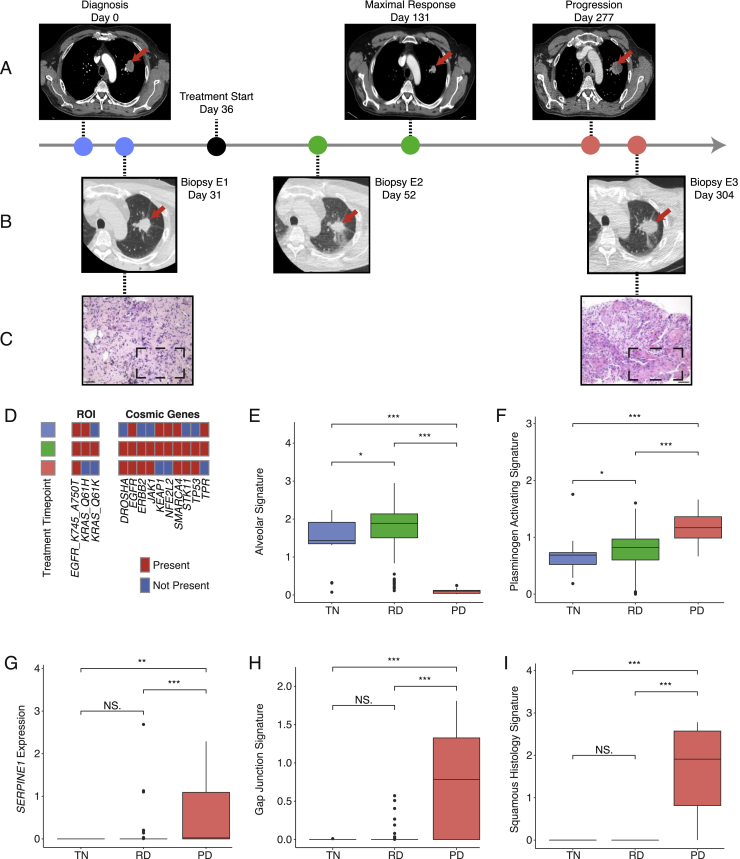
Related to Figure 3(A, B, C) Longitudinal timeline of patient treatment, (A) Chest CT scan at each clinical evaluation time point, (B) Biopsy time point with procedural CT scan, (C) Hematoxylin and eosin (H&E) staining from treatment naive and progression time points demonstrating adenocarcinoma and squamous cell carcinoma, respectively, scale bar indicates 50 μm. (D) Heatmap of mutation state in clinical driver and a subset of COSMIC tier 1 mutated genes (displayed COSMIC tier 1 mutations occur in at least two out of three samples). Color red indicates the presence of mutation whereas color blue indicates no presence of mutation. (E-I) Boxplots of pathway signature changes (alveolar, plasminogen activating, SERPINE1, gap junction and squamous histology, respectively) across treatment time points.